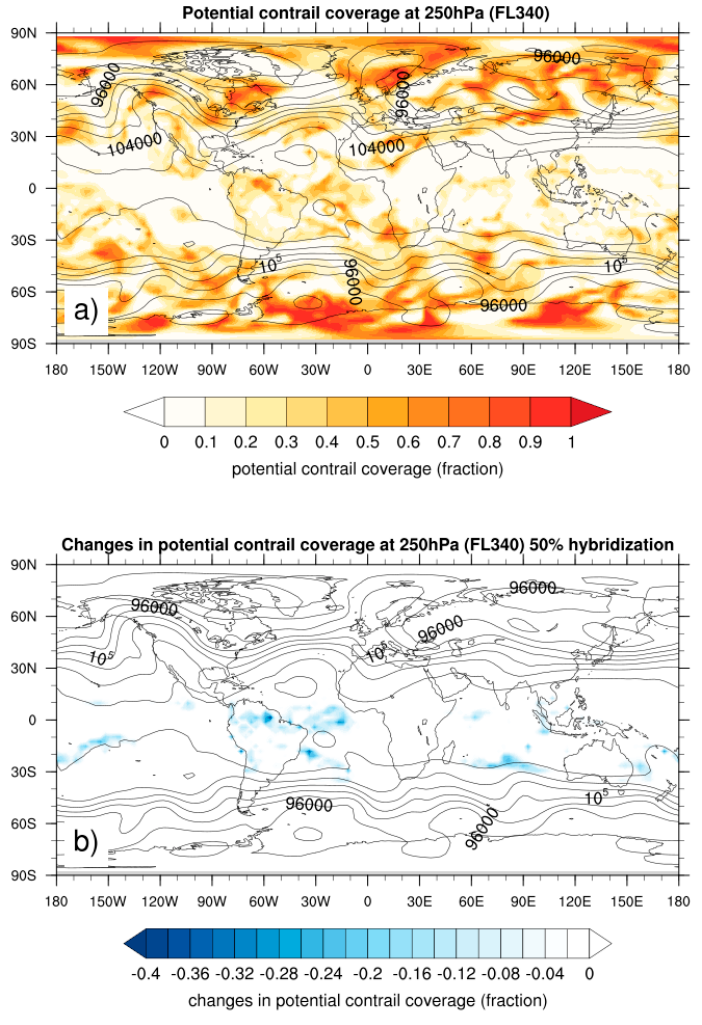
Figure 9. The PCC (contour) and geopotential (black contour; m 2 s − 2 ) at 250 hPa (FL340) on a specific day: ( a ) conventional aircraft; ( b ) absolute changes caused by HEA with 50% electric power.